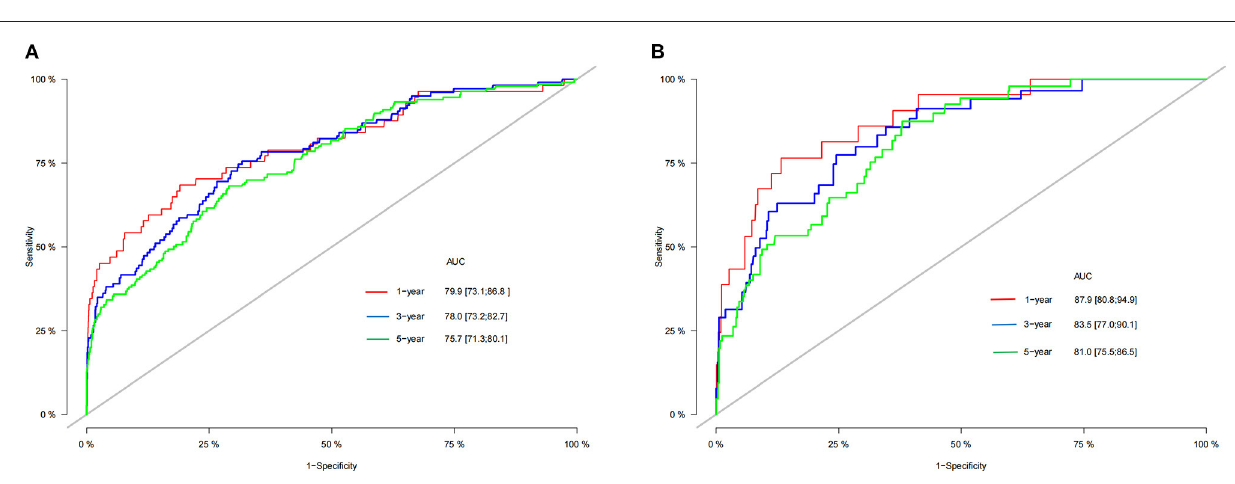
FIGURE 4 | AUC for predicting 1-, 3-, and 5-year CSS in training cohort (A) and validation cohort (B)